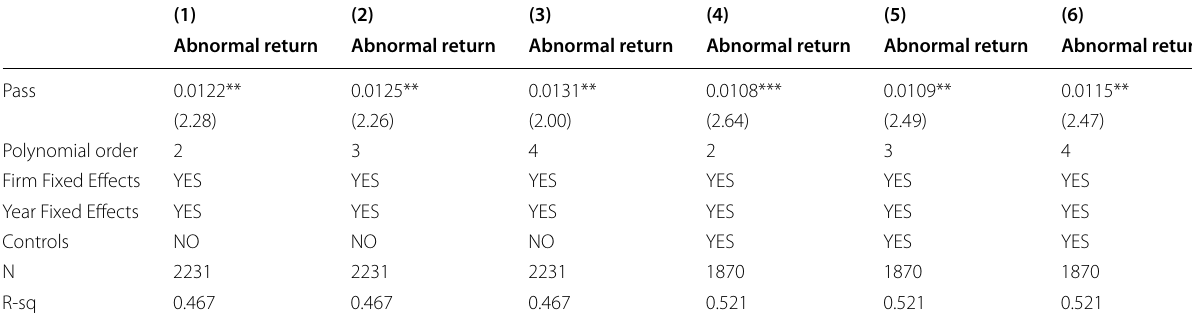
The dependent variable, abnormal return on the voting day, estimated from the Carhart [30] four-factor model. Column (1)–(3) adopt RDD without adding additional control variables. Column (4)–(6) includes the variables ROA, ROE, Net profit margin, Tobin’s Q, Labor productivity, Capital expenditures, Leverage, and Sales growth. Different polynomials of orders 3, 4, and 5 are adopted to conduct a robustness check. Standard errors in parentheses are clustered at the firm level. Significance at the 10%, 5%, and 1% levels is indicated